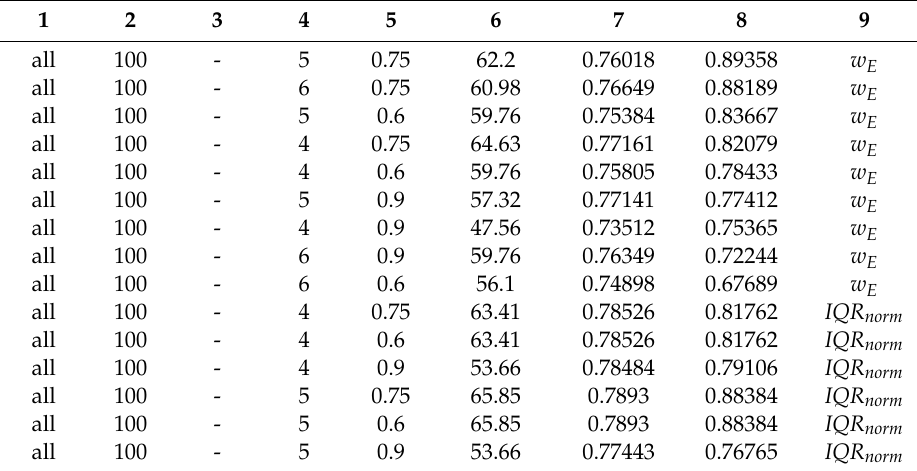
Table A1. Table of model results calculated to test and compare thresholds. (Due to geometry restrictions the header items are abbreviated and stated here: 1—Variable input, 2—Bu ff er size, 3—Weighting,